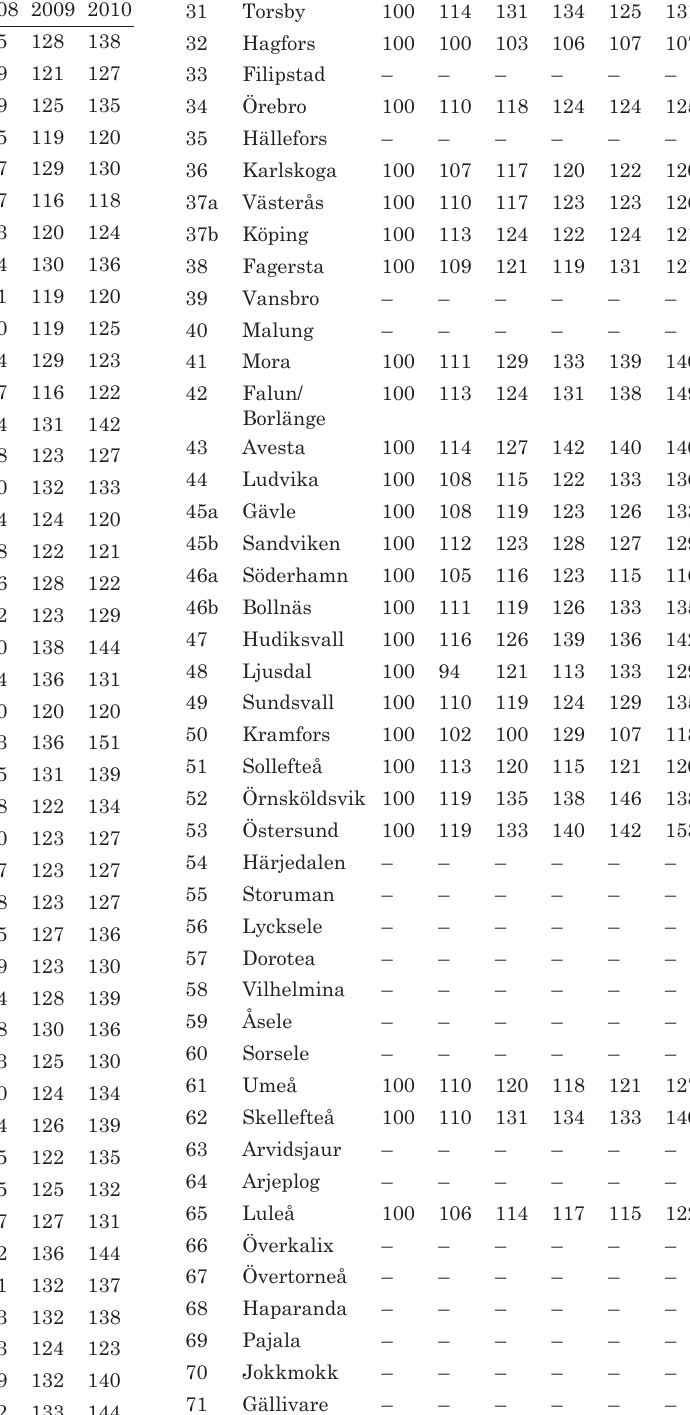
Table 10. Yearly price index series for each